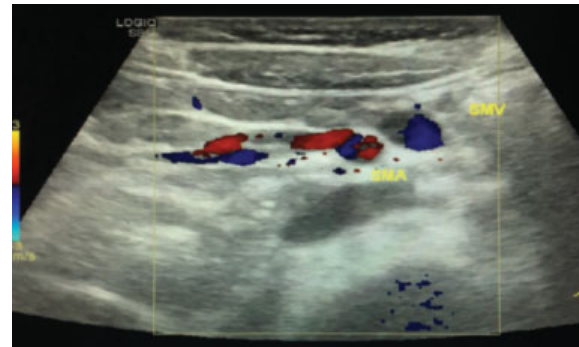
Fig. 4 Case 2: Doppler US image showing reversed relation of SMA and SMV done after the lower GI contrast study was suspicious of malrotation. GI, gastrointestinal tract; SMA, superior mesenteric artery; SMV, superior mesenteric vein; US,